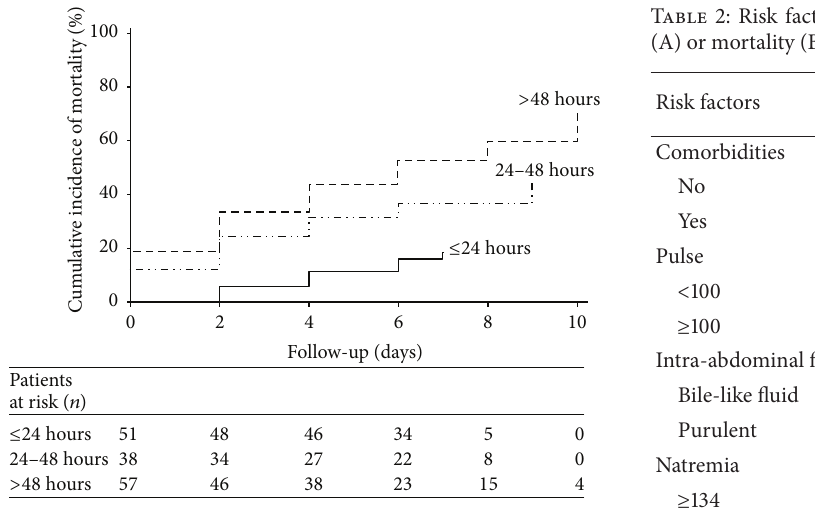
Figure 3: Cumulative incidence of postoperative mortality accord- ing to the delay of treatment.